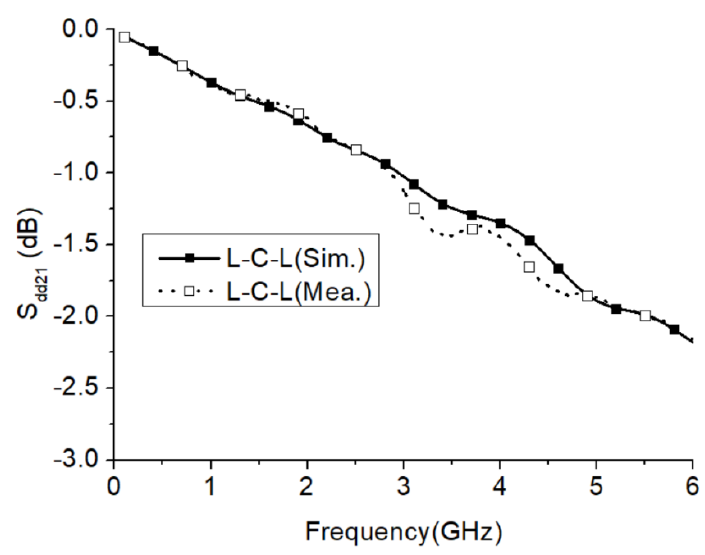
Figure 17. Comparison of measured and simulated results for Sdd21.